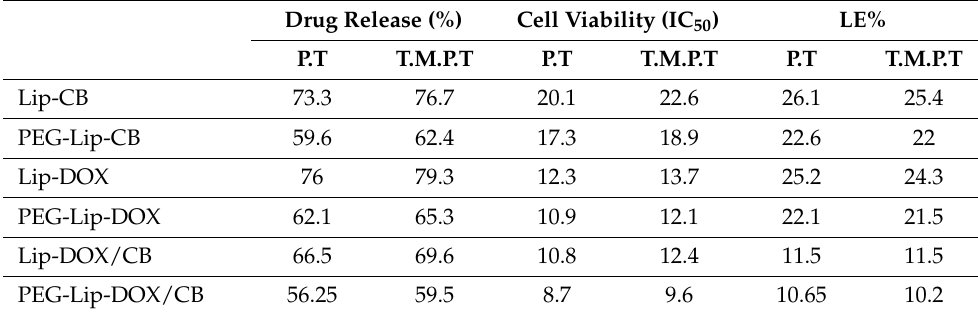
Table 4. The values of drug release, cell viability, and LE for Lip-DOX, Lip-CB, Lip-DOX/CB, PEG-Lip- DOX, PEG-Lip-CB, and PEG-Lip-DOX/CB at the preparation time and three months after preparation. Drug Release (%) Cell Viability (IC 50 ) LE% P.T T.M.P.T